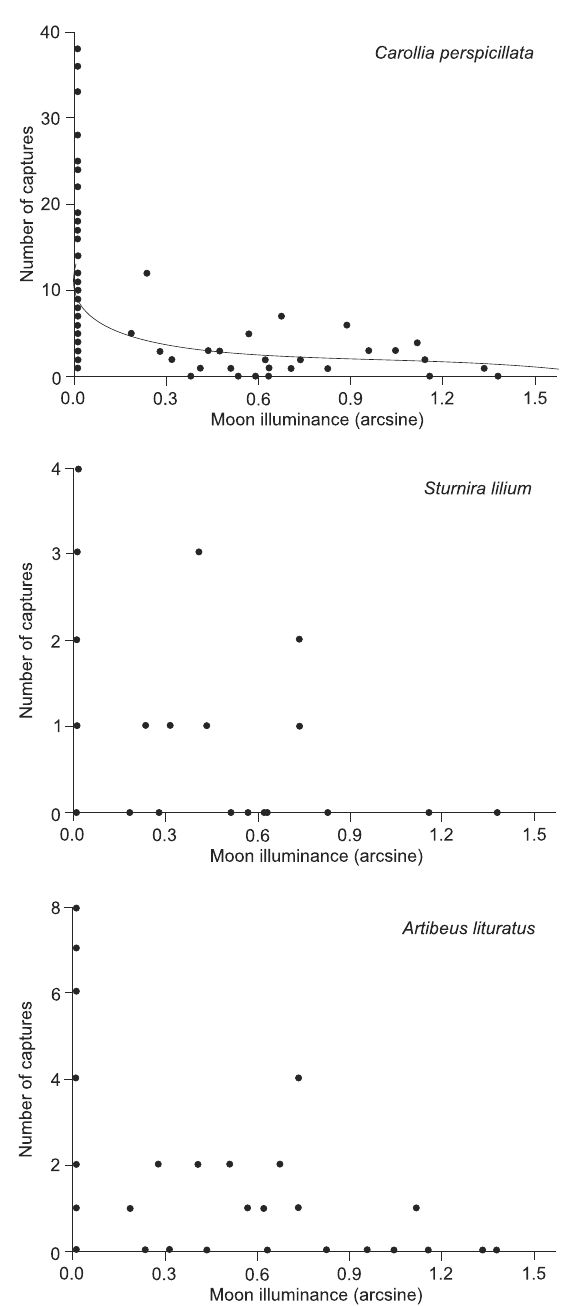
Figure 3. Variation in the number of captures of the bats Artibeus lituratus , Carollia perspicillata , and Sturnira lilium , in relation to moon illuminance in one-hour periods of 29 nights, in the Poço das Antas Biological Reserve, southeastern Brazil. this “within a night” scale, only the bat species C. perspicillata was captured less frequently in brighter periods of the night; there was no similar effect for the other two